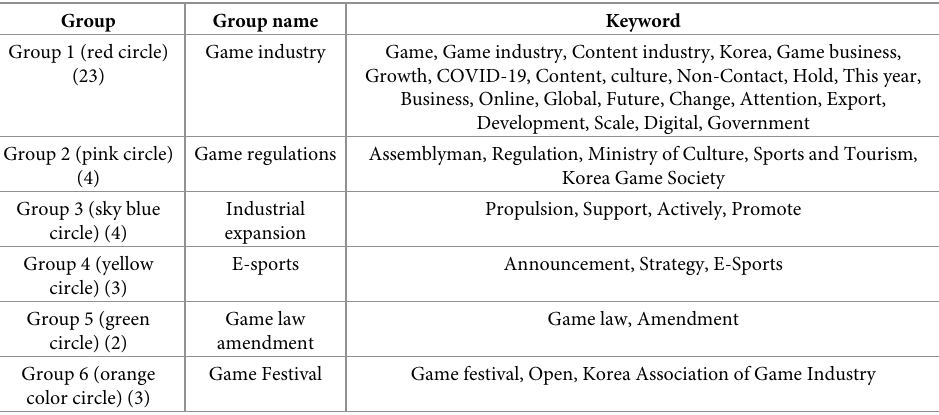
Table 5. The top 40 important keyword of game industry in